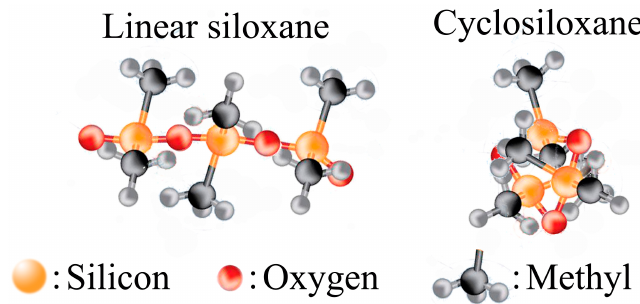
Figure 1. Molecular structure of the linear siloxane and cyclosiloxane.